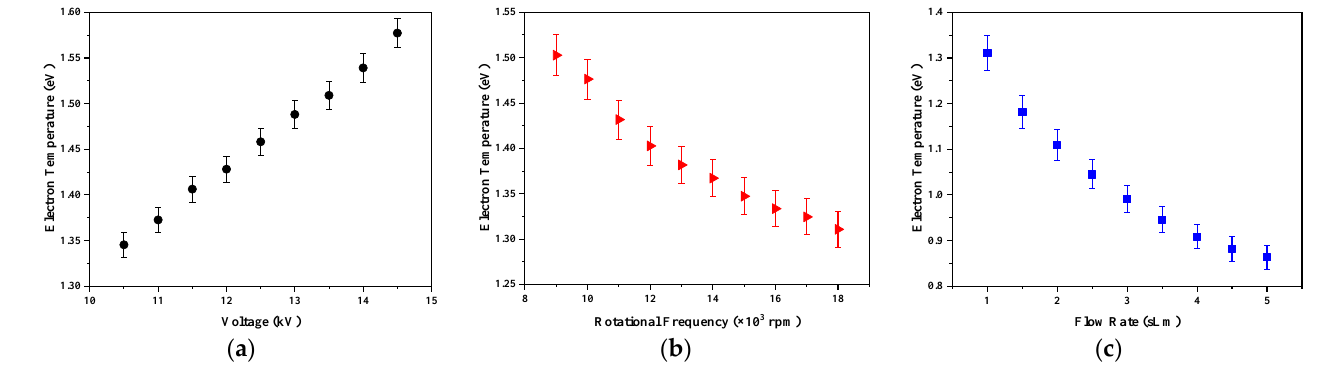
Figure 13. Changes of the electron temperature with different ( a ) applied voltages on the stationary power electrode and 1 sLm gas flow rate (3% error), ( b ) rotational frequencies of power electrode at 14 kV applied voltage and 1 sLm gas flow rate (2% error), and ( c ) gas flow rates at 14 kV applied voltage and 18,000 rpm rotation frequency of the power electrode (2% error).